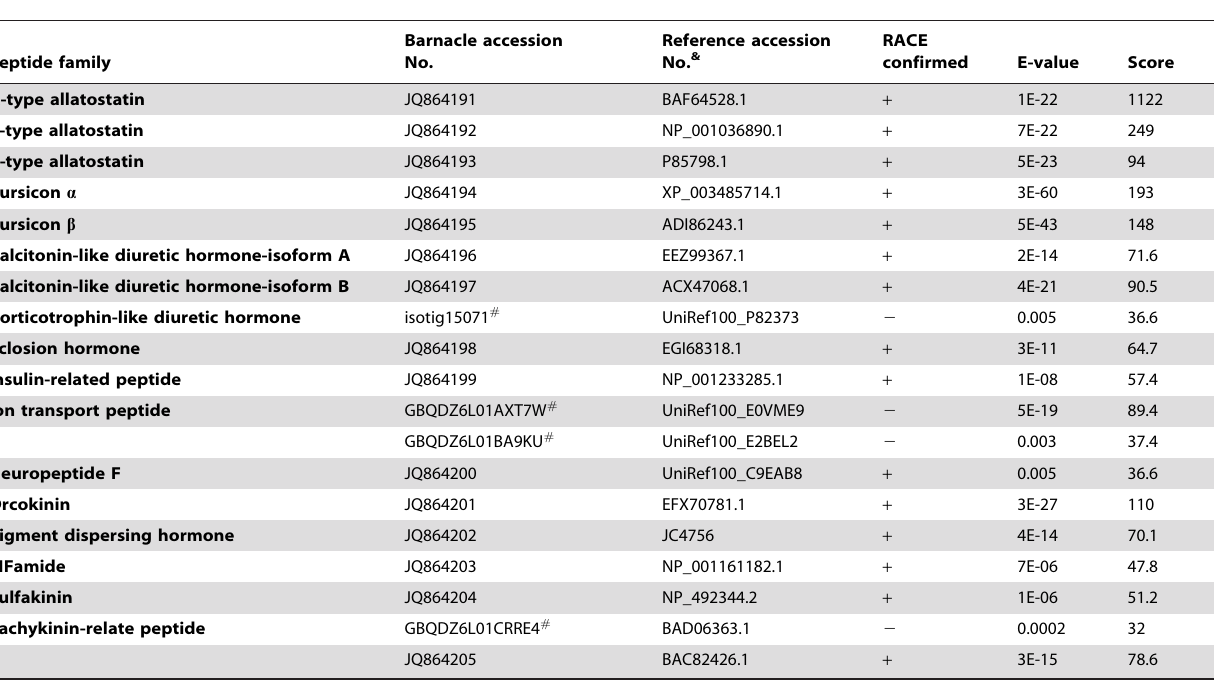
Table 1. Neuropeptide/peptide hormones predicted based on transcriptome mining of Balanus amphitrite .